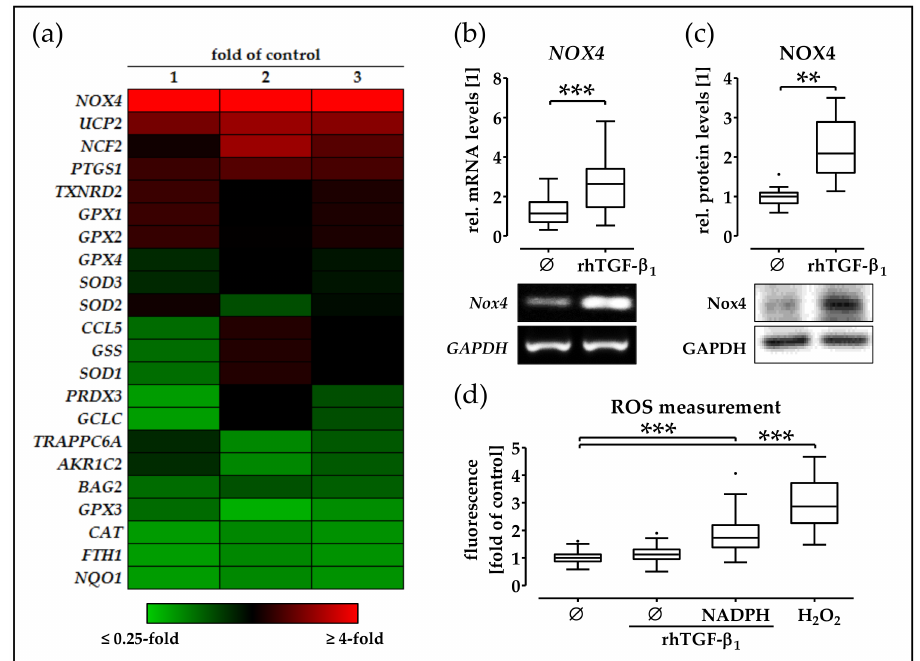
Figure 4. rhTGF- β 1 induces expression and activity of nicotinamide adenine dinucleotide phosphate (NADPH) oxidase 4 ( NOX4 ) in phOBs. ( a ) Expression of oxidative stress-related genes was determined using the human RT 2 Profiler PCR Array Oxidative Stress Plus (Qiagen, Hilden, Germany), in phOBs ( N = 16/pooled; n = 2) cultured in an osteogenic medium for 48 h in the presence or absence of 5 ng/mL rhTGF- β 1 . Data are presented in heat map, showing relative expression levels in rhTGF- β 1 -treated cells in comparison to untreated cells. To confirm the results, 9 individual donors ( N = 9; n = 2) are cultured in the osteogenic medium for 48 h in the presence or absence of 5 ng/mL rhTGF- β 1 . ( b ) NOX4 mRNA levels were determined by semi-quantitative RT-PCR. ( c ) NOX4 protein levels are determined by Western blot. Band intensities were quantified using the ImageJ software. ( d ) NOX4 activity in cultured (48 h ± 5 ng/mL rhTGF- β 1 ) phOBs ( N = 6, n = 4) was determined indirectly by measuring the formed ROS with the DCFH-DA assay. NADPH was added as a substrate for NOX4 . H 2 O 2 was used as a positive control. Data are represented in box blots (Box and Whiskers—Tukey to visualize outliers). ** p < 0.01 and *** p < 0.001 as